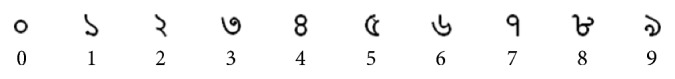
First row shows the Bangla actual digits and second row shows the corresponding Arabic numerals.